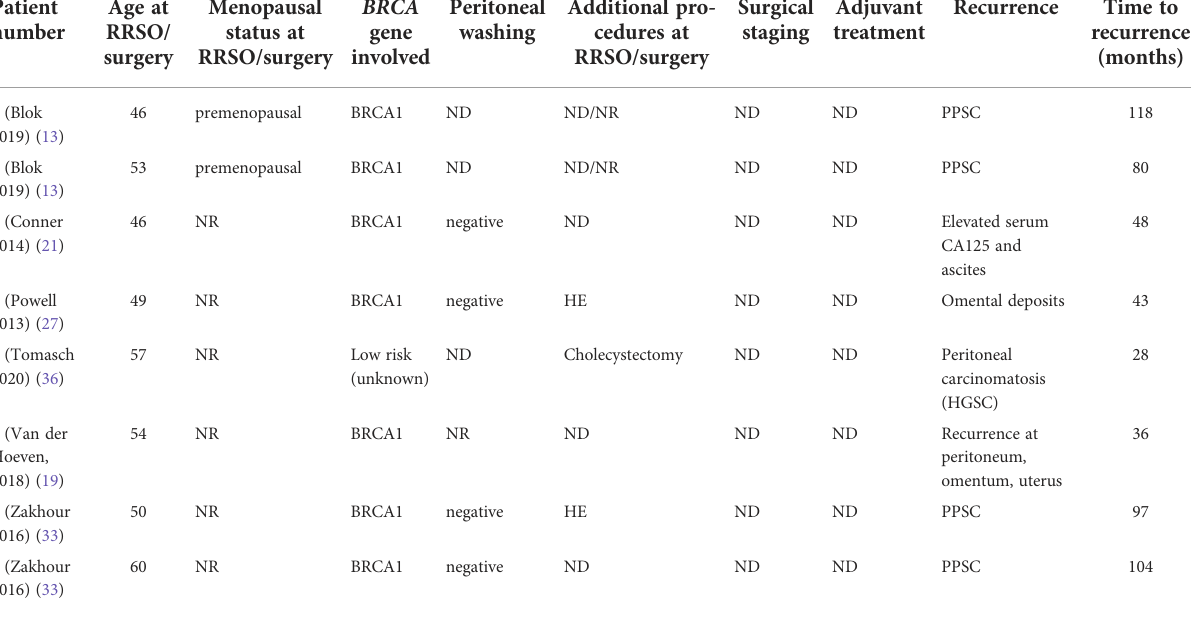
TABLE 4 Characteristics of the eight STIC patients with subsequent